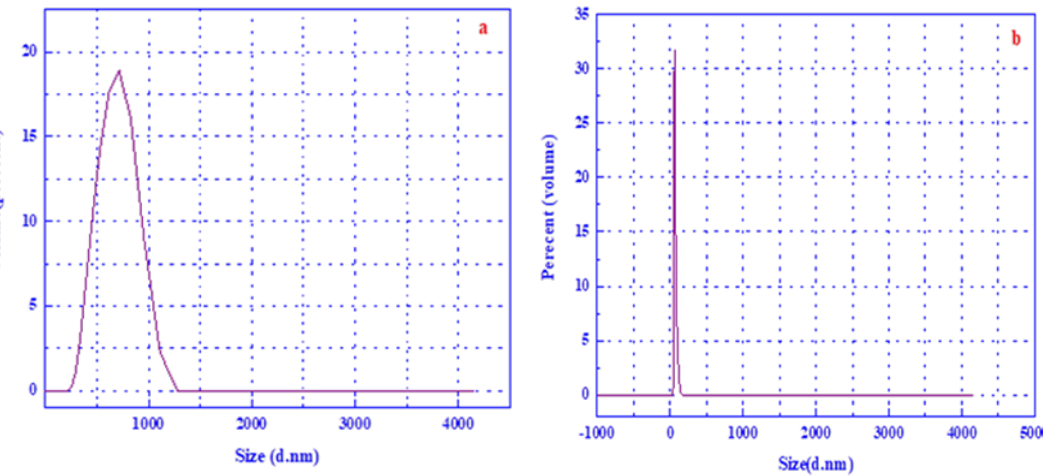
Figure 2. Particle size distribution of synthesized ( a ) Fe-AC; ( b ) ZnO-NPs samples.